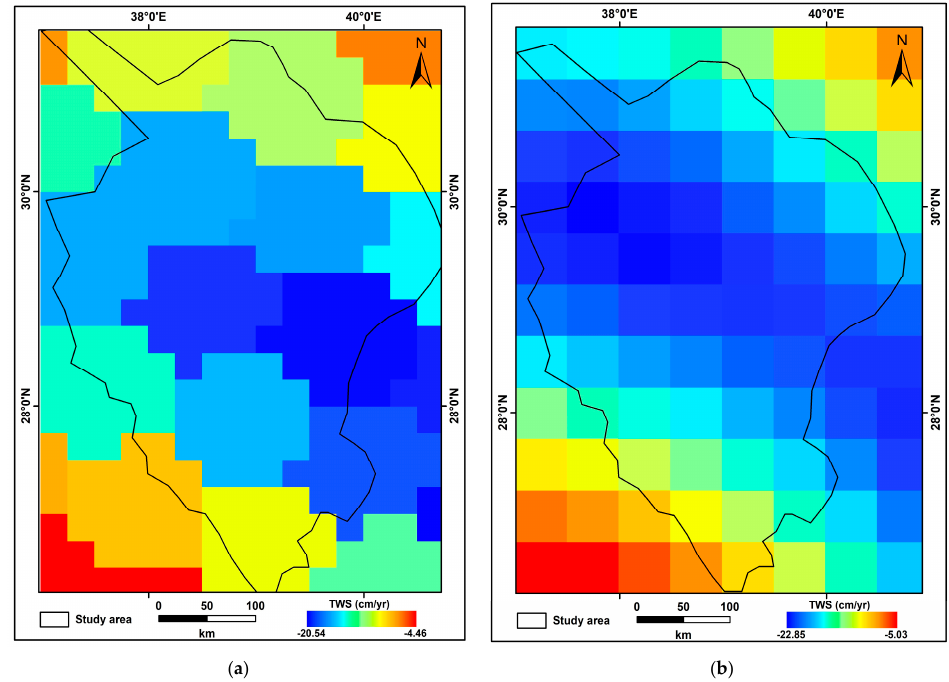
Figure 4. Monthly TWS estimates from April 2002 to December 2021, produced from CSR ( a ) and GFCF ( b ) data, are displayed on a map with a color-coded secular TWS trend (mm yr − 1 ). Using GRACE estimates of Δ TWS for the research area, Figure 5 shows the monthly fluctuations in storage anomalies. Higher negative Δ TWS trend values, assessed at − 12.32 ± 0.36, − 13.3 ± 0.019, and − 15.84 ± 0.31 mm/yr (Table 1) using CSR, JPL, and GFCF mascon solutions, respectively, for the study region over the studied period. The averaging of the three Δ TWS solutions for Wadi As-Sirhan during that period yielded a value of − 13.82 ± 0.24 mm/yr (Table 1; Figure 5). Table 1. Δ TWS parts (mm yr − 1 ) for the entire study region with a confidence level of 95%.